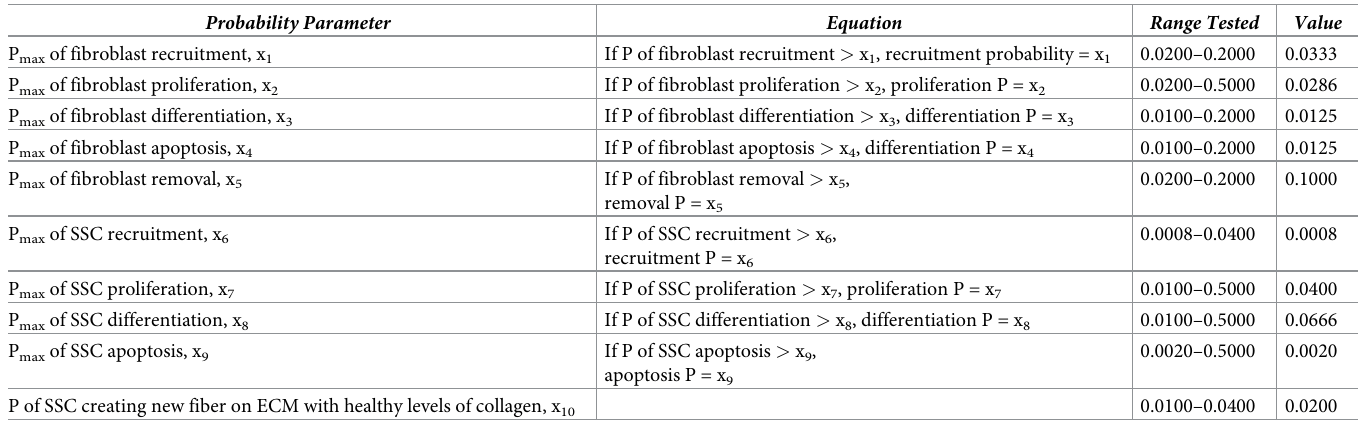
Table 4. Unknown model probability parameters (x) were tuned to recapitulate published experimental results. P is probability and P max is maximum probability. Probability